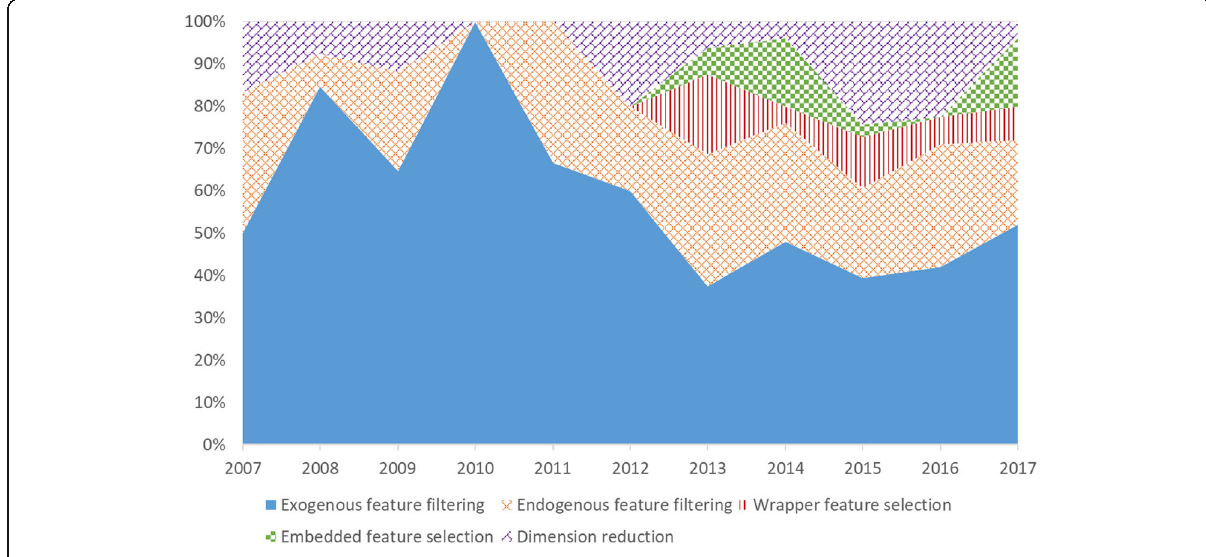
Fig. 4 Dynamics of FSE methods ’